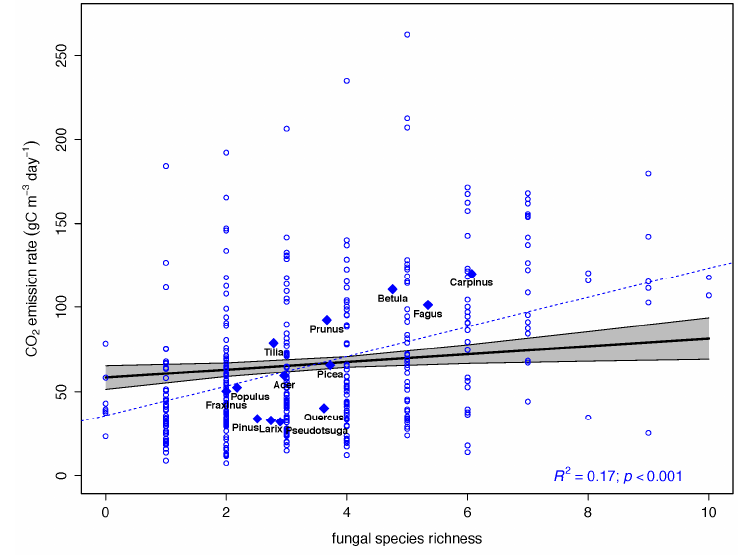
Figure 3. Relationship between CO 2 emission rates and the significant explanatory variable wood temperature for the best-fit global model. Solid regression line and the surrounding grey 95% confidence interval shows the significant main effect and is corrected for the influence of the other variables in the best-fit global model. The blue data points represent field observations from 355 logs. The blue dashed regression line represents the linear correlation based on the field observation data.